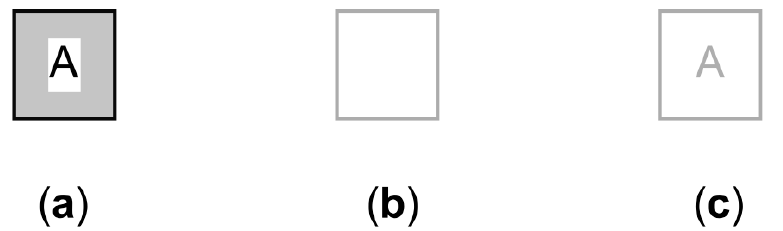
Figure 9. Identity-Based Change , the three basic states: ( a ) existing object , ( b ) non-existing object without history , ( c ) non-existing object with history (redrawn from [43] ).